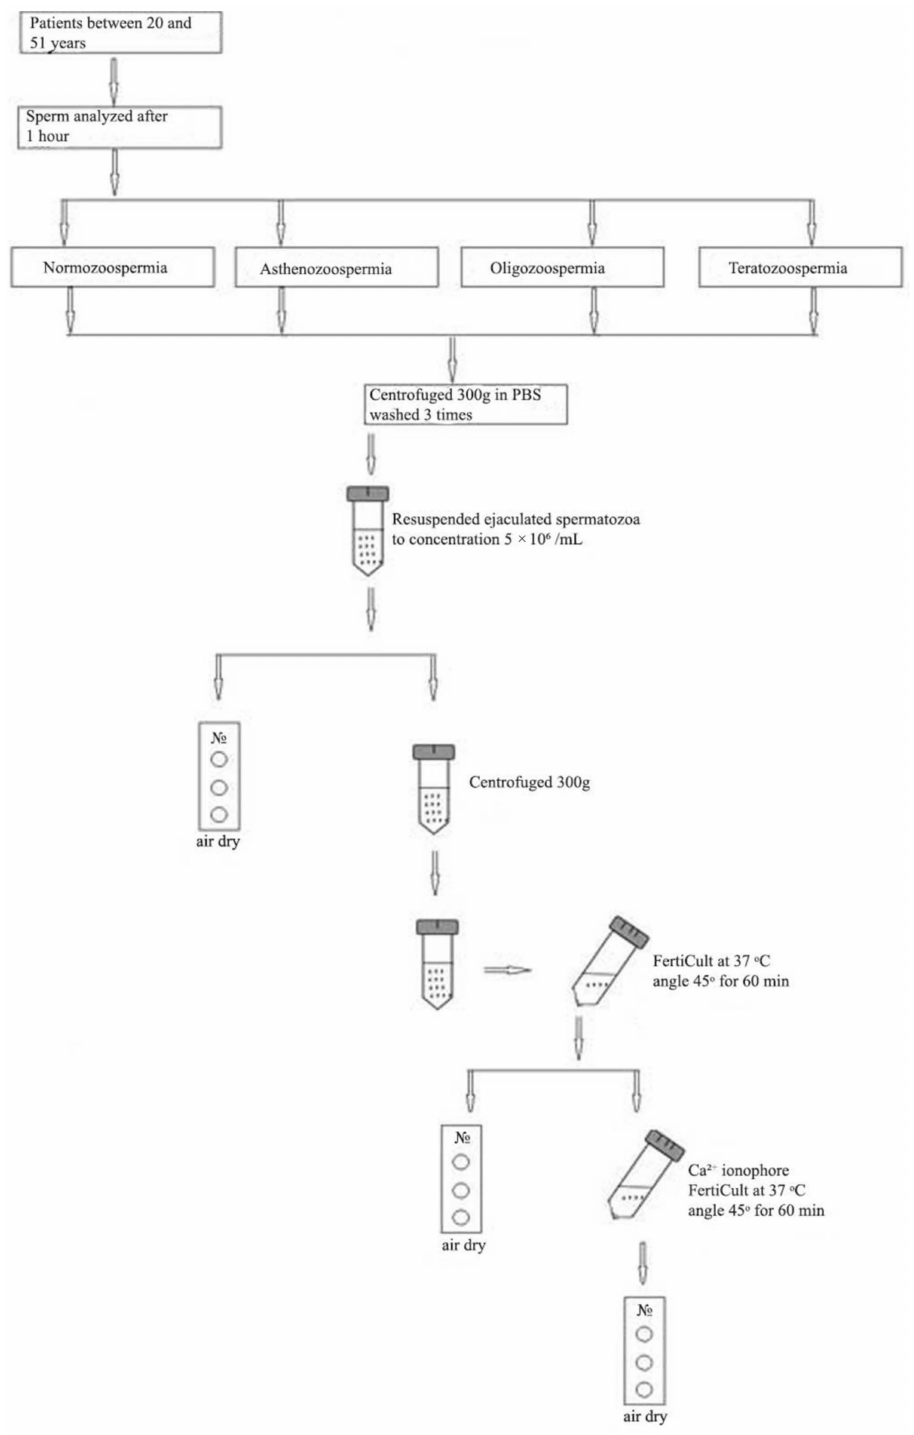
Figure 1. Schematic representation of sperm